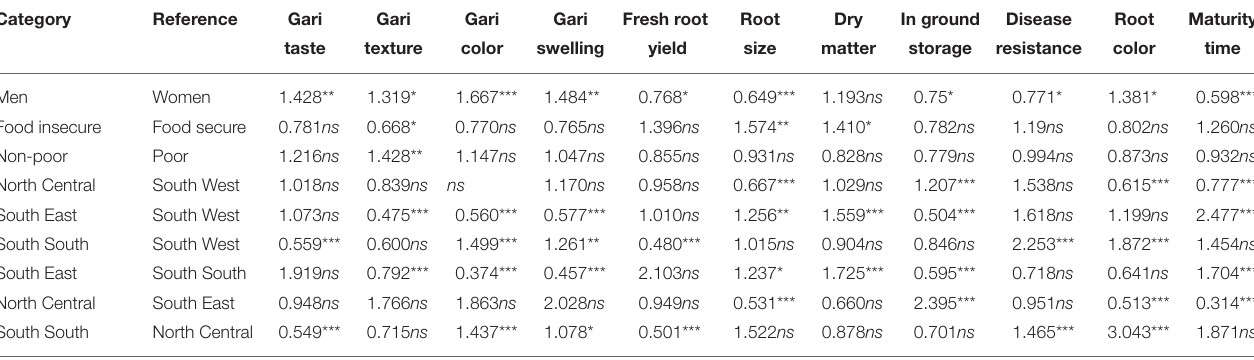
TABLE 2 | Odds ratio estimates for the differences between women and men, Food Secure vs. Food Insecure and Non-poor vs. Poor, and between the different regions for each of the 11 traits. Category